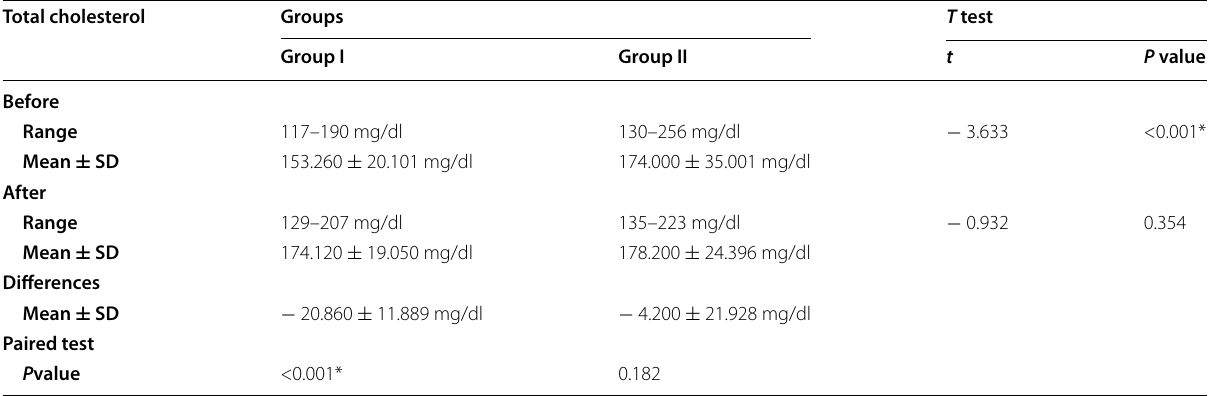
t Student’s t test, p p value for comparing between the two groups